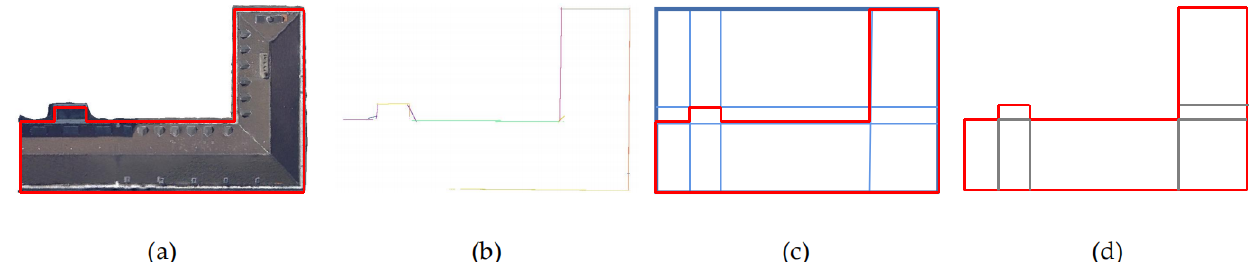
Figure 2. Illustration of the generation of auxiliary edges by combining the point cloud and footprint: ( a ) building point cloud and its footprint; ( b ) line structures of the building extracted from the point cloud; ( c ) the partition using interior line segments; ( d ) the red polygon denotes the footprint data, and the gray lines denote the auxiliary edges.